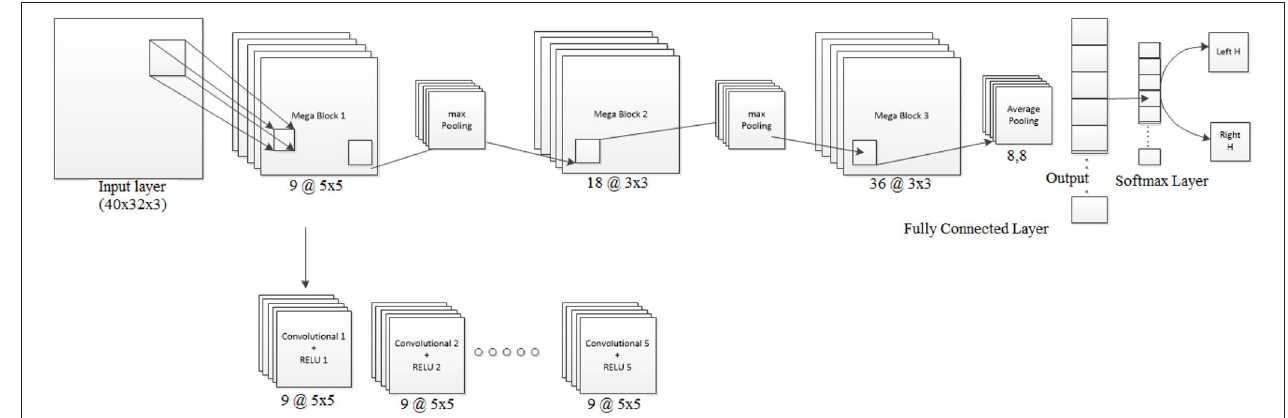
FIGURE 4 | Visualization of Architecture-2 for inter-subject classification. Lines represent the connection between the feature maps. The Mega Block is the combination of 5 convolution blocks of the same size and number of filters. The number of convolution blocks required is learned through Bayesian optimization. The network can extend itself from 3 convolution layers to 15 or more convolution layers, depending on the amount of data and noise level. The optimization works by defining the objective function and finding its minimum observed value. The network designed is useful for representing the input data in small dimensional representation to avoid